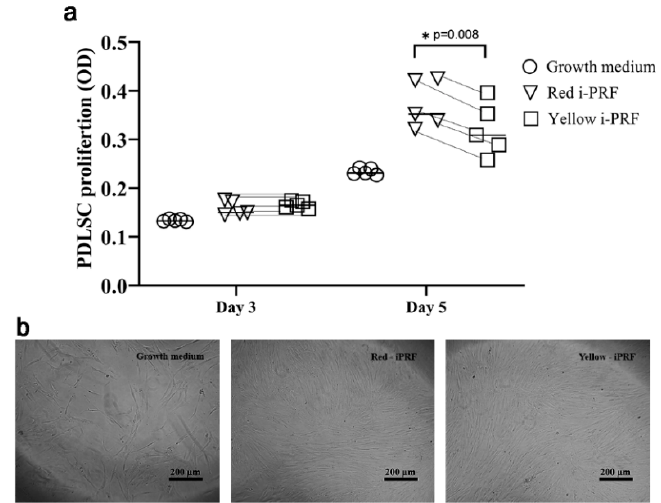
Figure 2. Proliferative effects on periodontal ligament stem cells. ( a ) Cell culture medium containing the release from the red i-PRF enhanced cell proliferation significantly greater than the medium consisting of the release from the yellow i-PRF at day 5. ( b ) Live cell images of cell number in the different culture mediums (scale bars = 200µm). Significance was assessed using one-way ANOVA followed by post hoc least-significant difference tests to compare the differences between groups. The data are shown as individual donor pairs. * p<0.05.